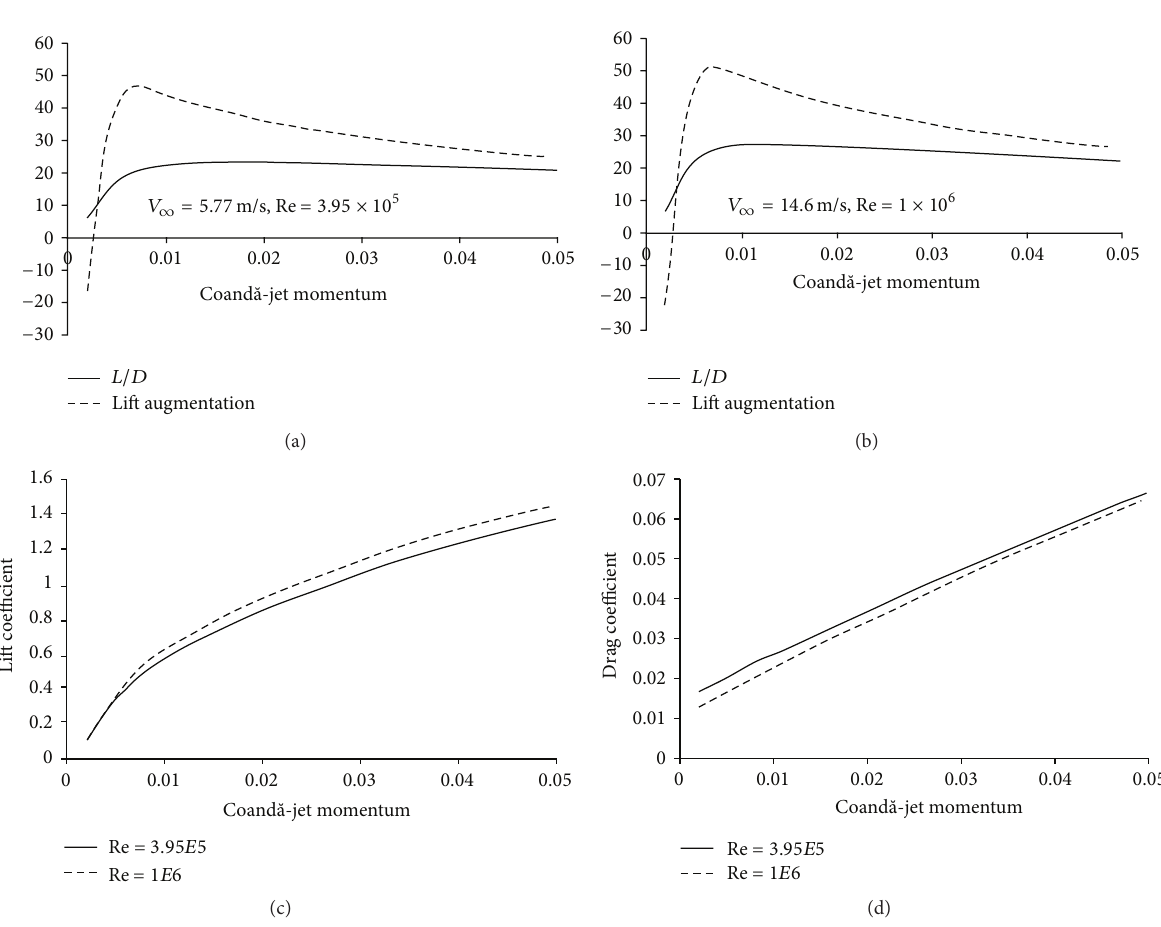
= 50mm, 𝑡 = 1mm); (a) Re = 3.95 × 10 5 ; (b) Re = 1.0 × 10 6 TE jet